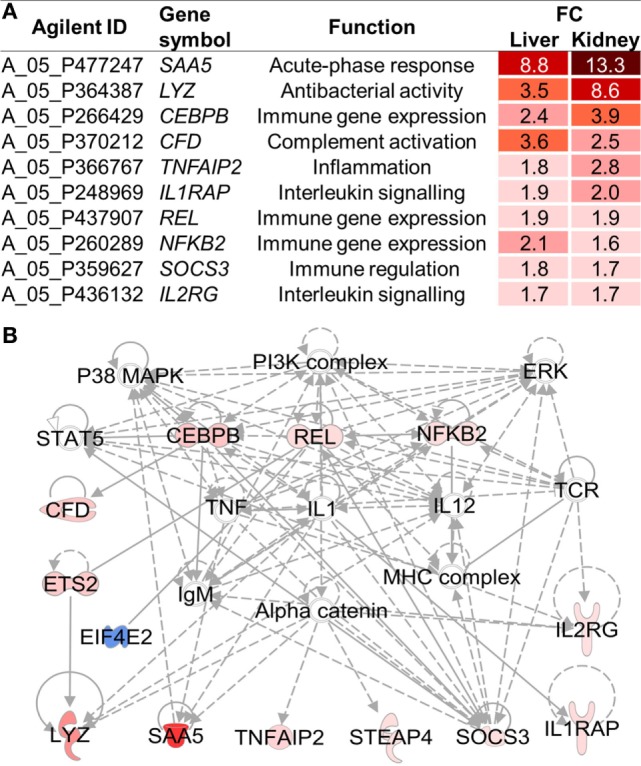
(A) Among the 53 high density (HD)-induced genes shared by the liver and kidney (cf. Figure 1C), 10 genes were involved in innate immunity, as assessed using the Ingenuity Pathway Analysis program. (B) Based on these 53 shared genes, an IPA network was constructed, including all 10 immune genes. Red and blue symbols indicate up- and downregulated genes, respectively, in HD vs. moderate density whitefish. Full and broken lines indicate direct and indirect relationships, respectively. Open and filled arrows represent an influence on translocation and activation as well as protein–protein or protein–DNA interactions, respectively.